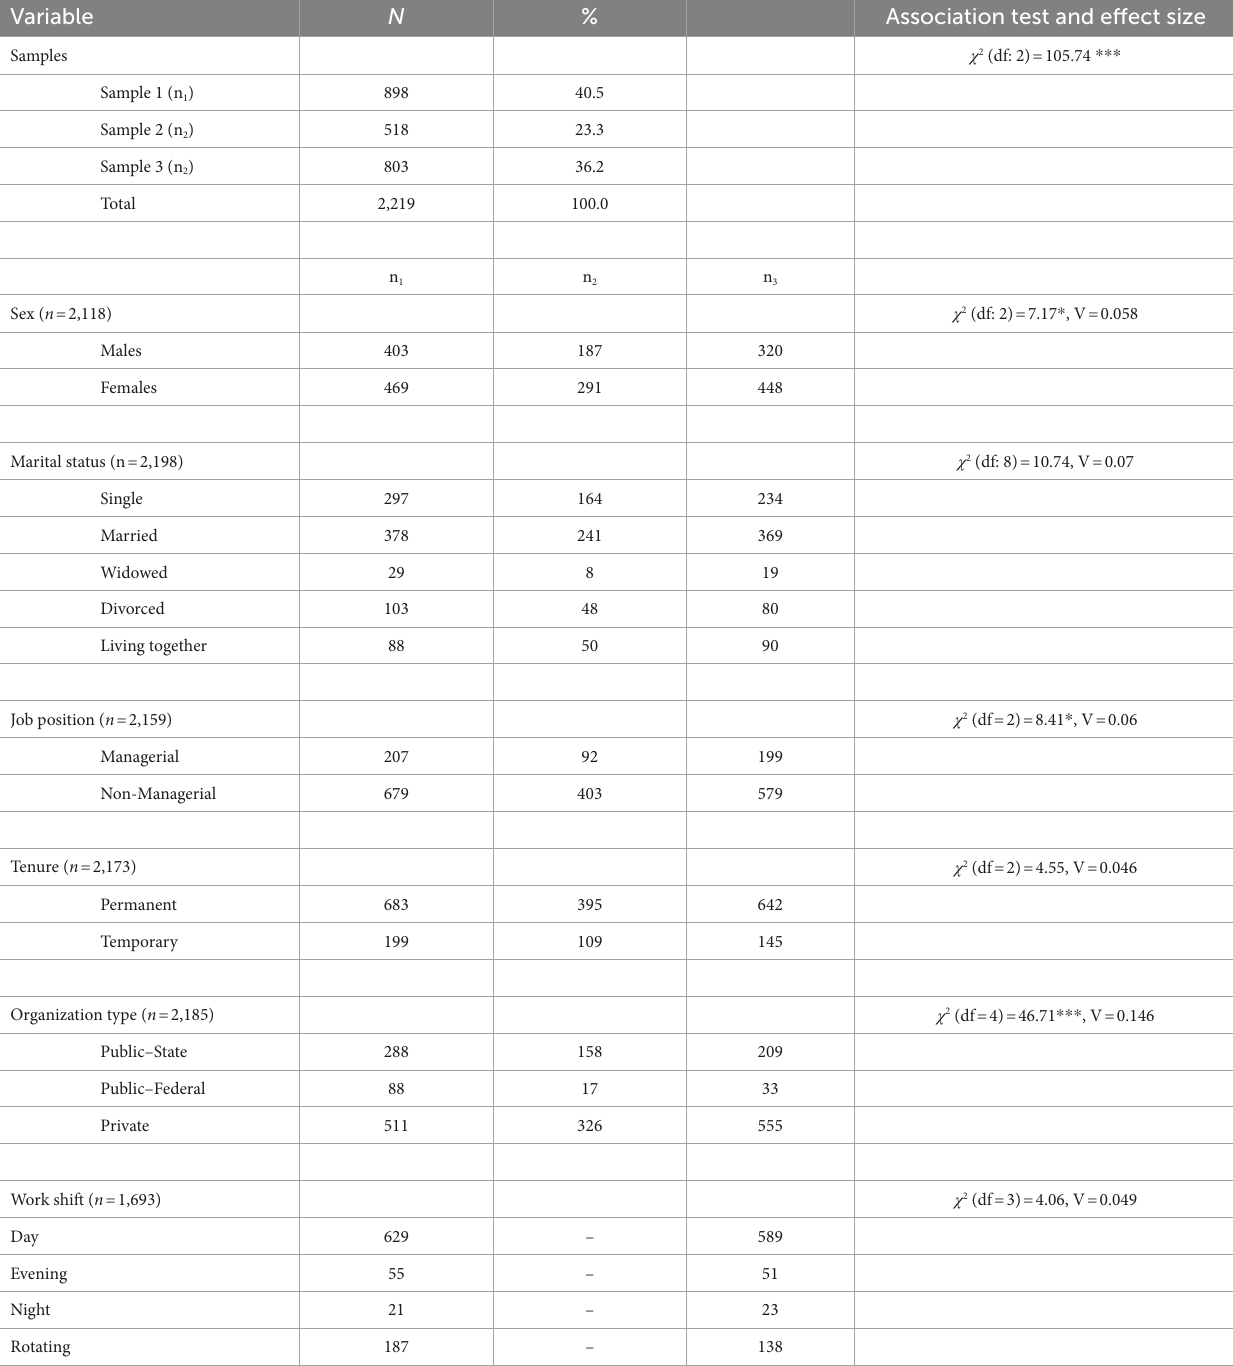
TABLE 1 Sociodemographic characteristics of the sample. Variable N